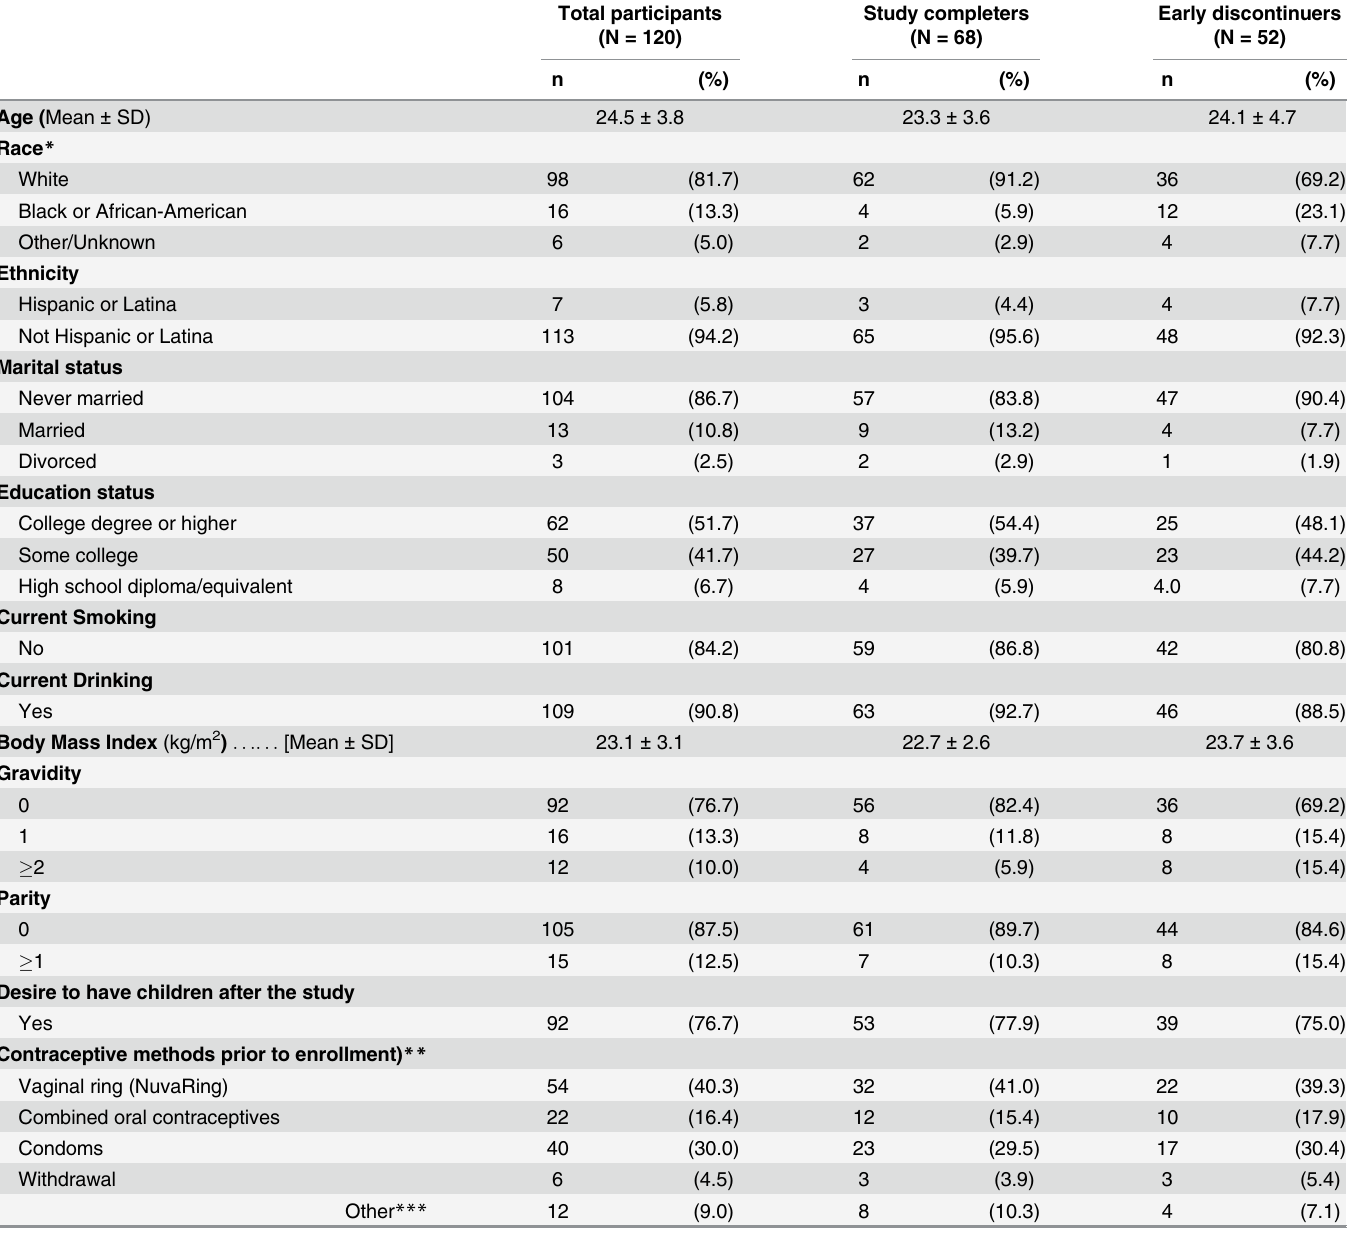
Table 1. Demographic and baseline characteristics among substudy